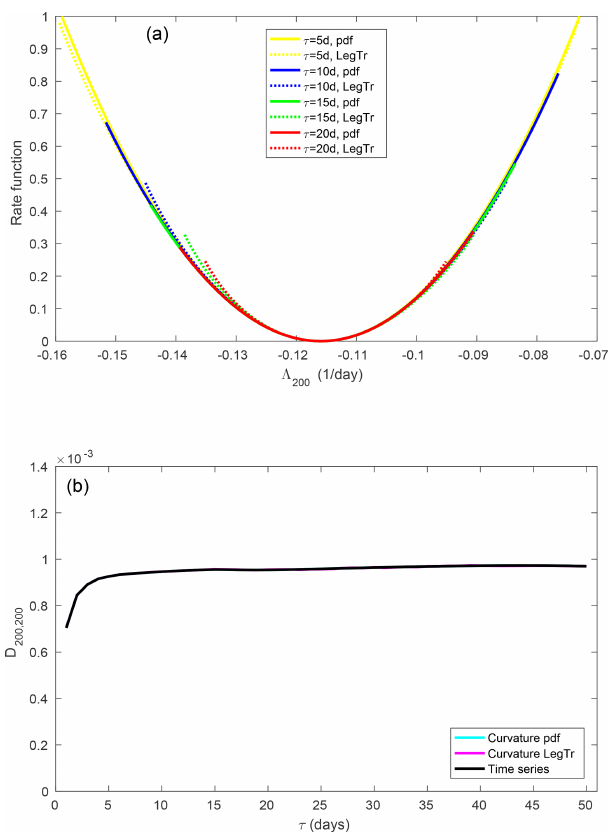
Figure 10. (a) Large-deviation rate function of the 200th FTLE. (b) Element D 200 , 200 of the diffusion matrix.